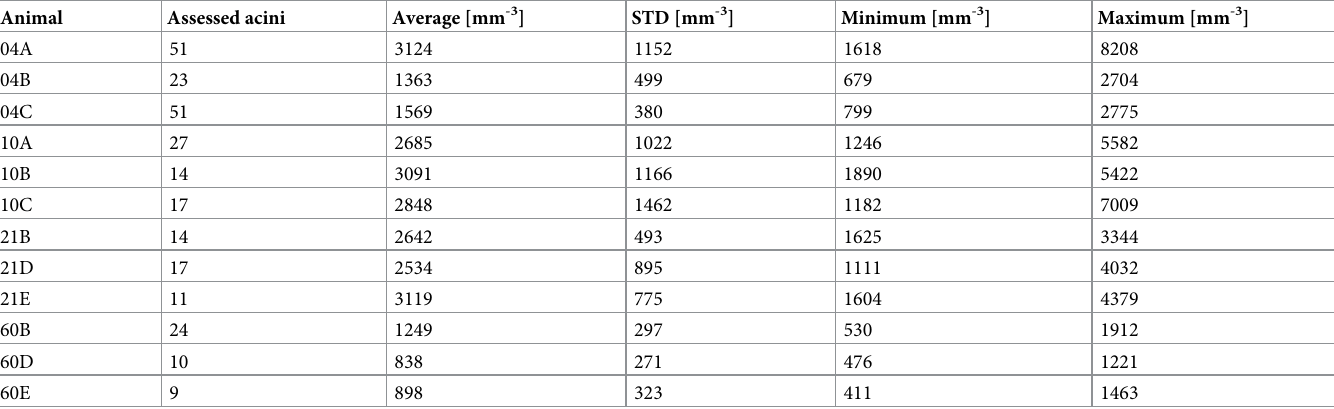
Table 3. Details of alveolar density (number per mm 3 ) per acinus volume for each animal.